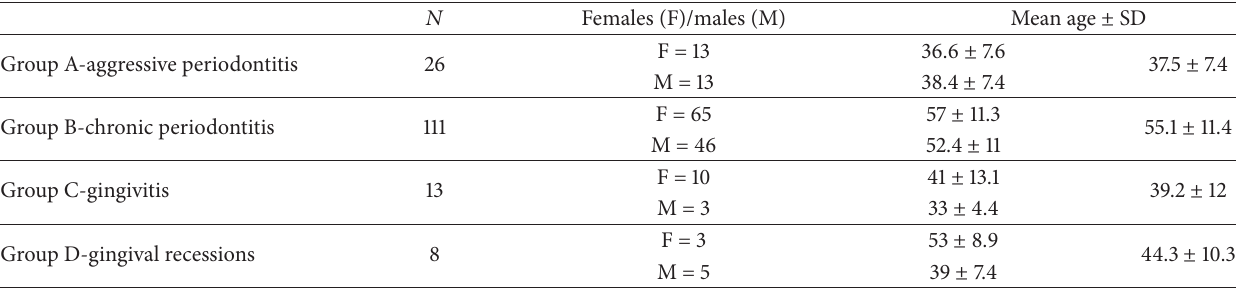
Table 1: Groups of patients: characteristics.